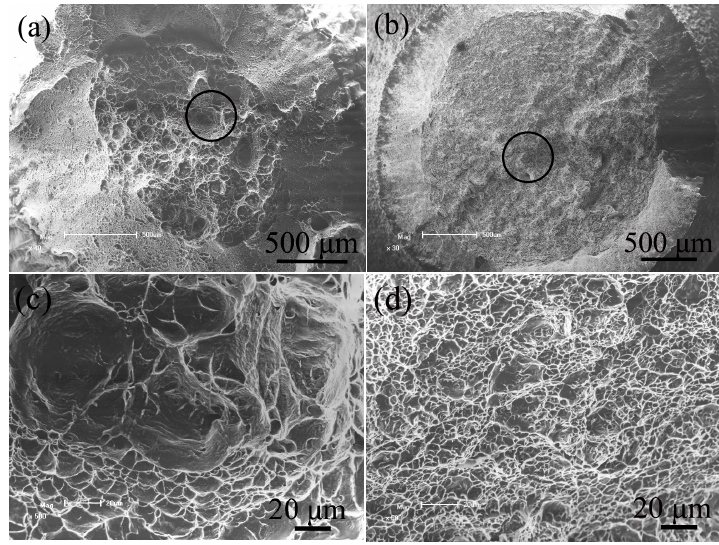
Figure 7. Tensile fractographies of the alloys: ( a , c ): alloy C1; ( b , d ): alloy C2.